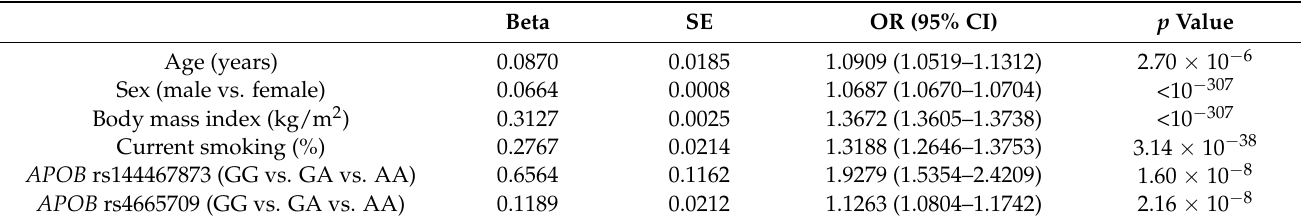
Table 4. Logistic regression analysis: metabolic